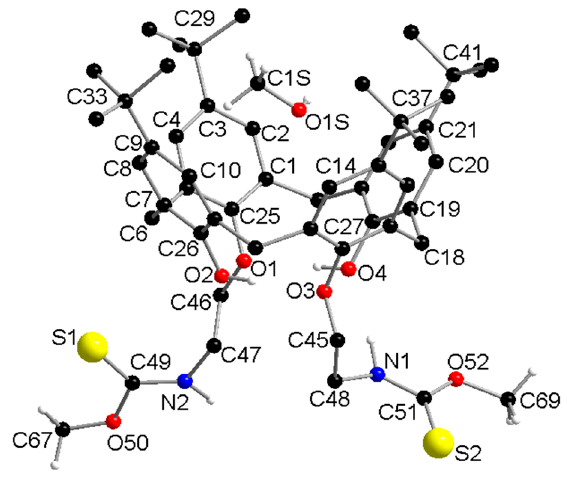
Figure 3. Crystal structure of compound ( 4 ). Some H-atoms has been omitted by clarity.